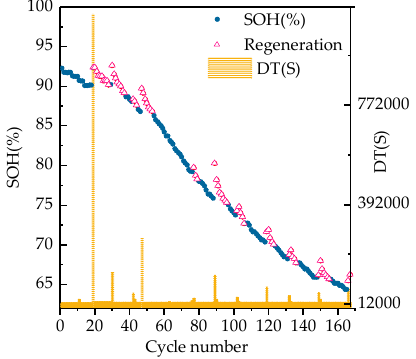
Figure 1. Degradation curve of the state of health (SOH) with cycle number and calendar time for #5 battery.